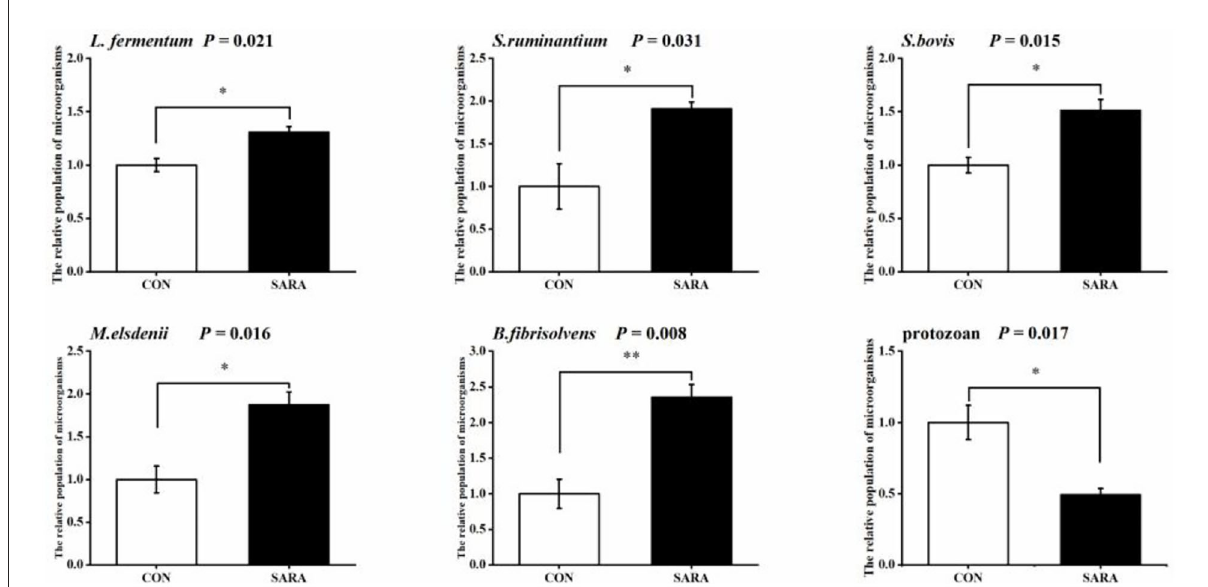
FIGURE7 The variation of the relative populations of microorganisms in rumen fluid. Data were expressed as mean ± SEM ( n = 6). Significant differences are denoted by * P < 0.05, and extremely significant differences are indicated by ** P < 0.01.